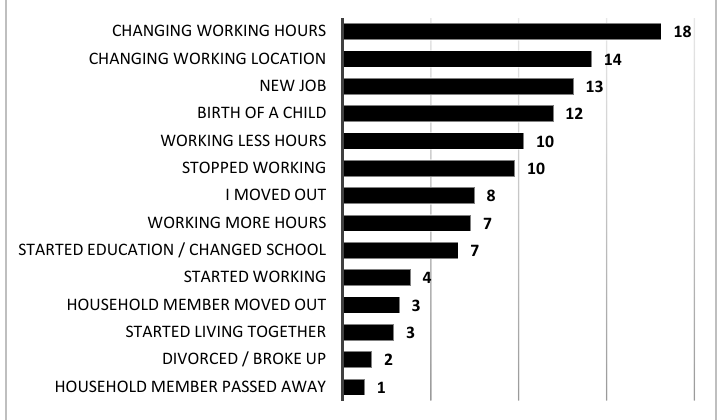
Figure 2. Frequency of life events (%) in the selected sample in the years